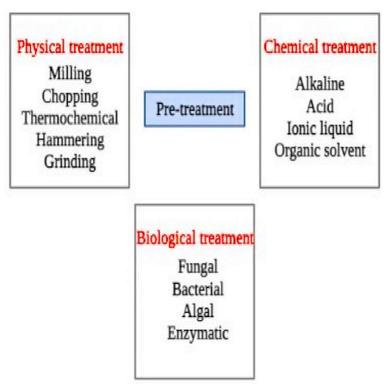
Various methods of pre-treatment process for the conversion of agro waste biomass.